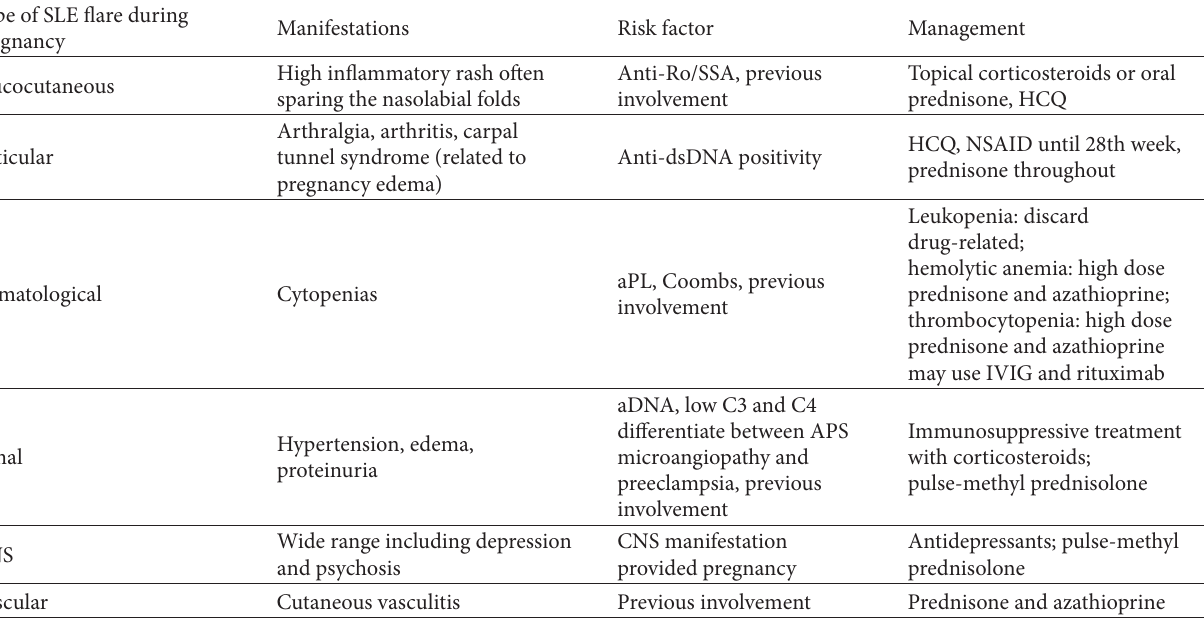
Table 2: Type of SLE flare during pregnancy, manifestations, risk factor, and